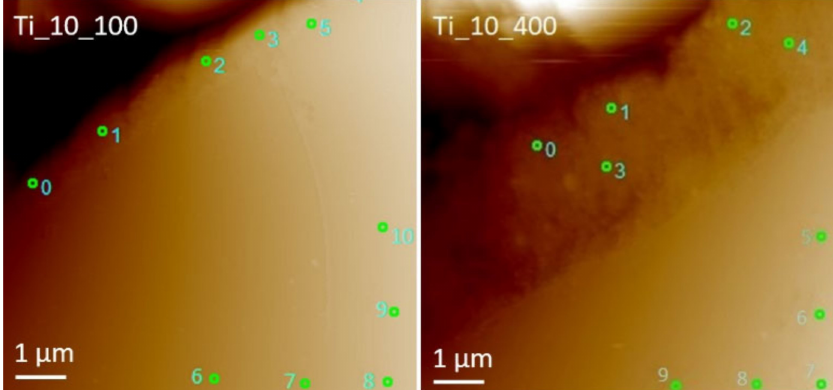
Figure 10. AFM image showing individual nano-indentation measurements.